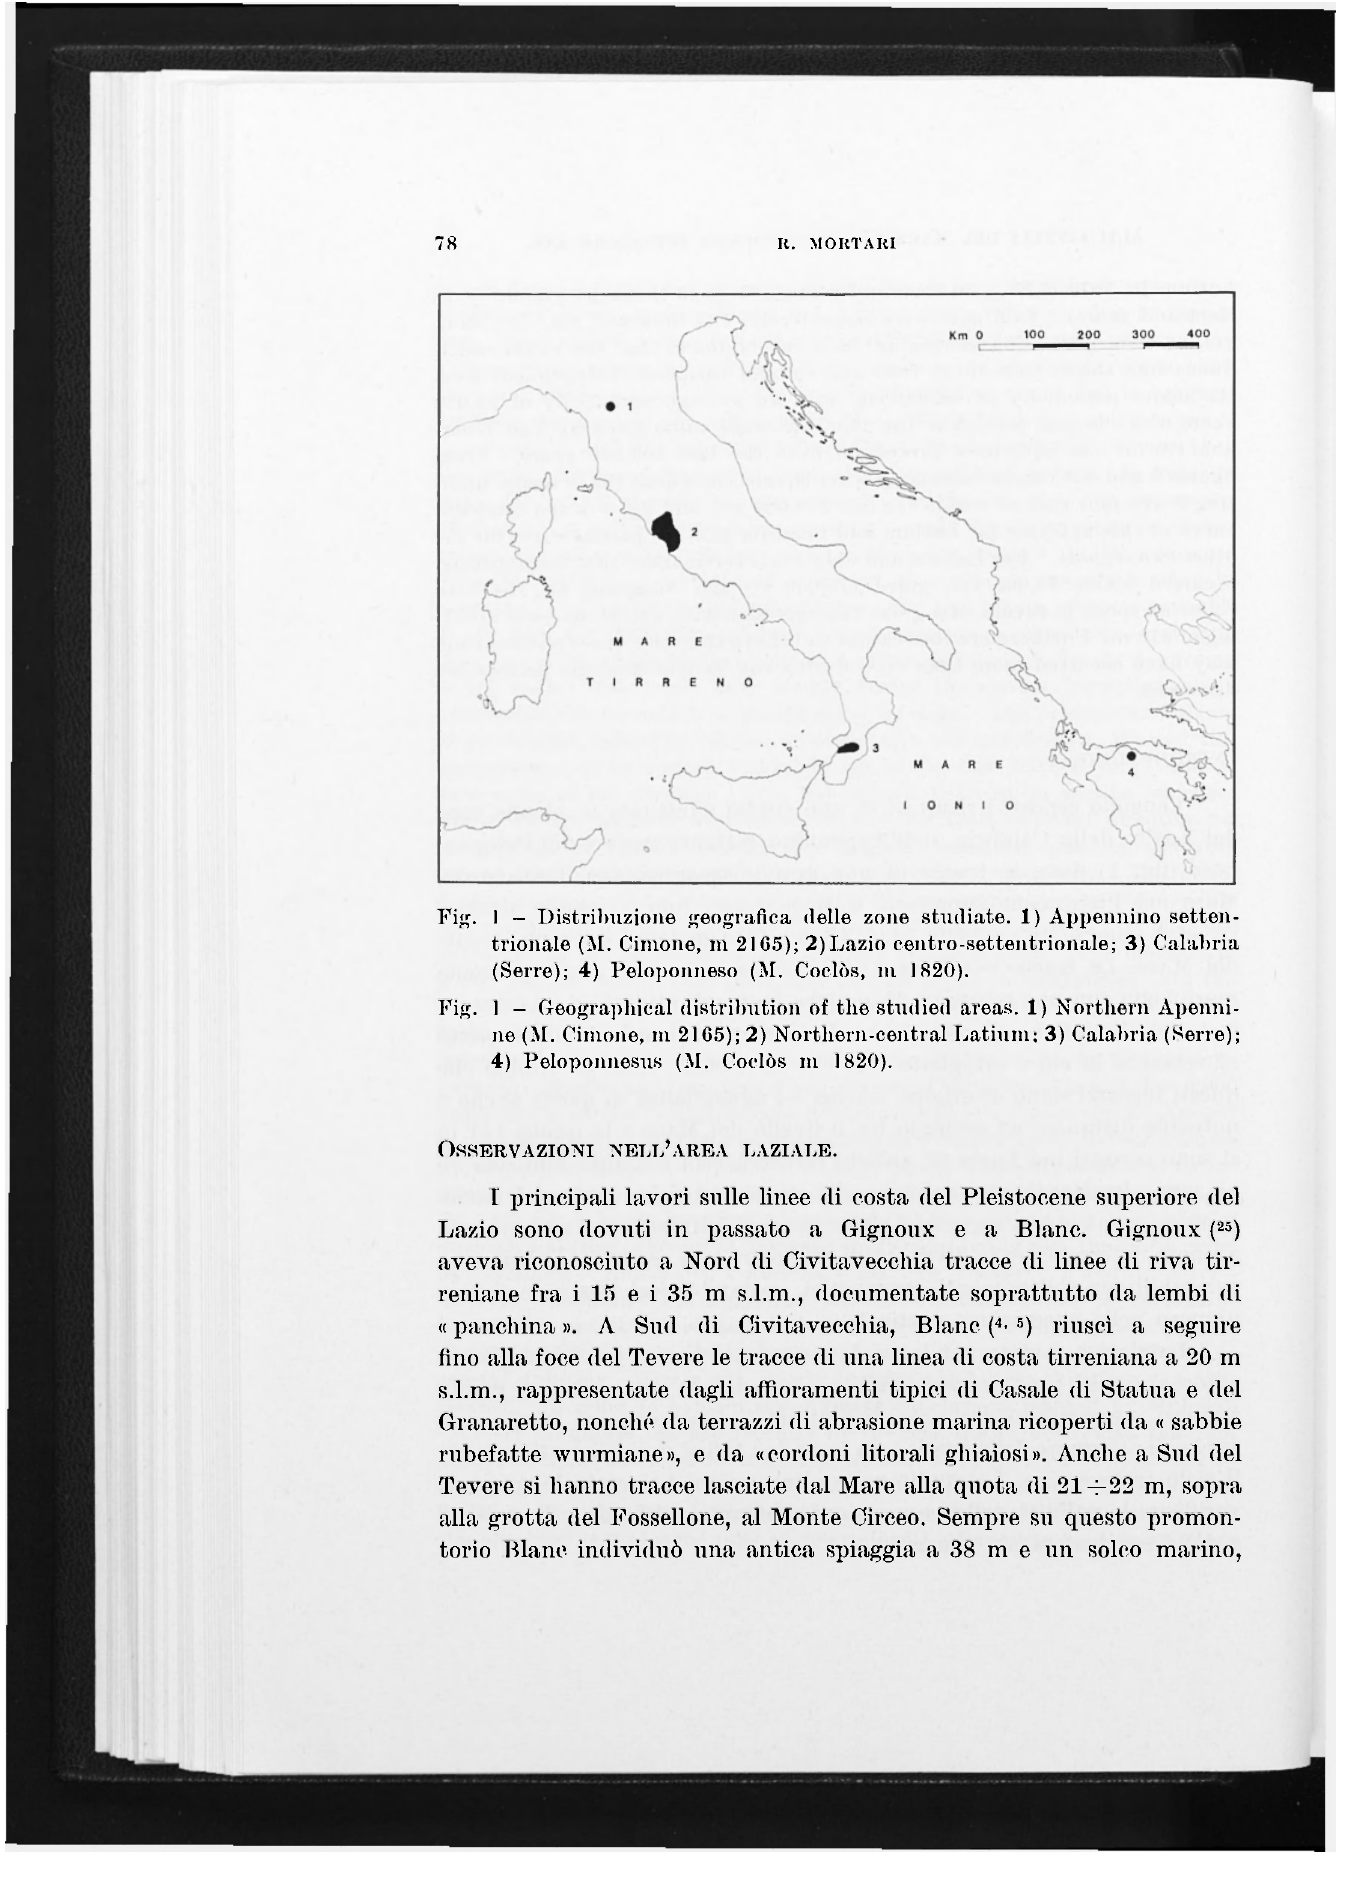
Distribuzione geografica delie zone studiate. 1 ) Appennino setten- trionale (M. Cimone, m 2165); 2)Lazio centro-settentrionale; 3) Calabria (Serre); 4) Peloponneso (M. Coclòs, m 1820). Fig. 1 - Geographical distribution of the studied areas. 1) Northern Apenni- ne (M. Cimone, m 2165); 2) Northern-central Latium: 3) Calabria (Serre); 4) Peloponnesus (M. Coclòs m